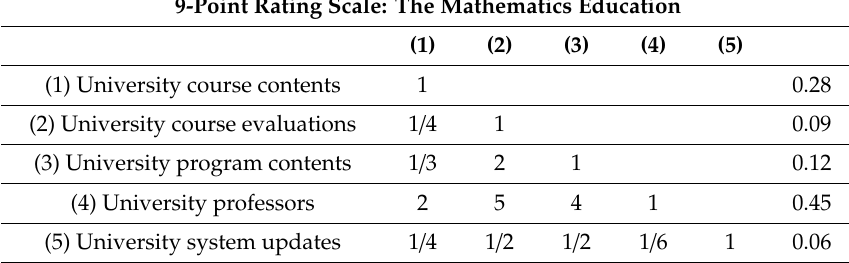
Table 3. The mathematics education criteria computation of the five sub-criteria, along with a pair-wise comparison